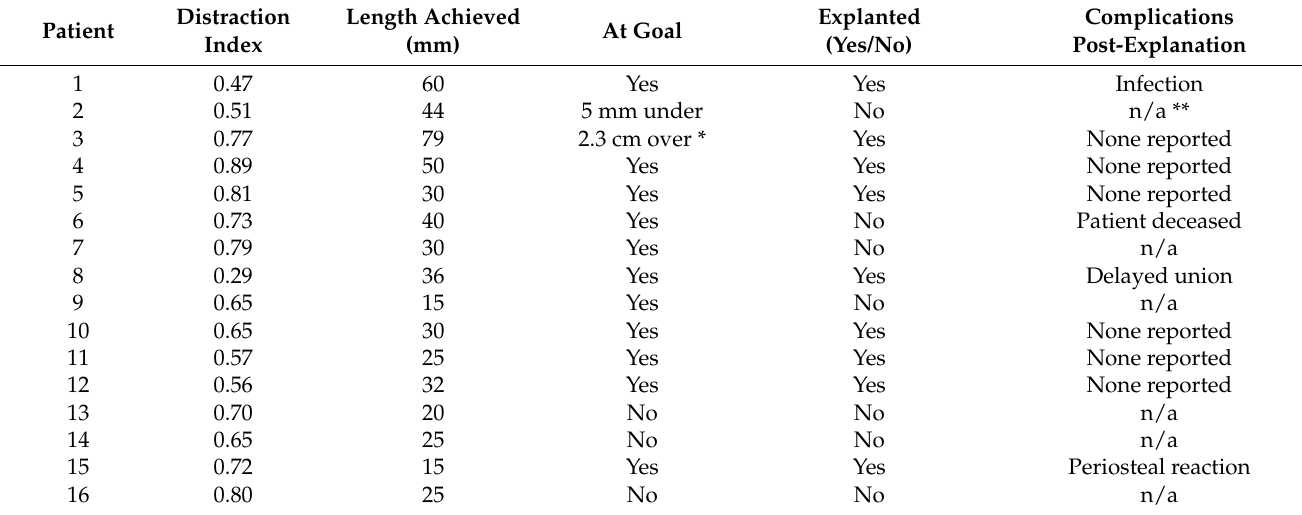
Table 3. Lengthening outcomes of patients aged ≥ 60 years.